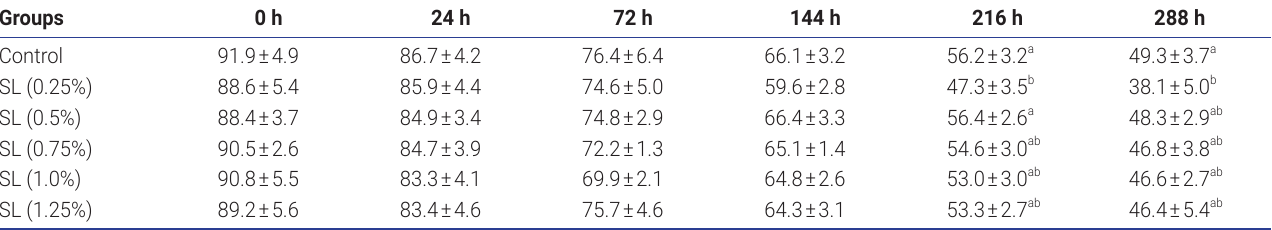
Table 1. Progressive motility of Duolang rams’ sperm stored at 0°C in diluents with different levels of soybean lecithin (mean±standard error of mean) Groups 0